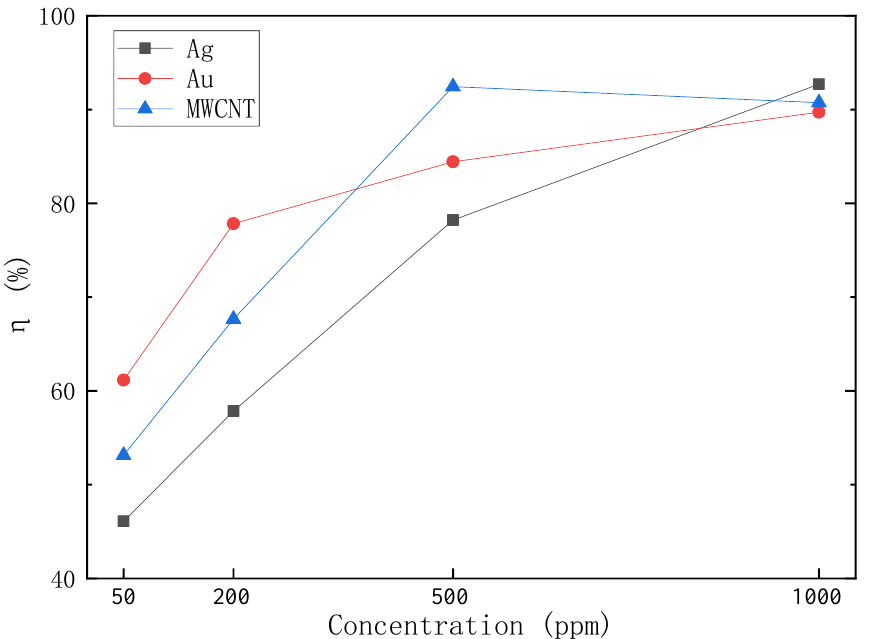
Figure 12. Solar–thermal conversion efficiency of Ag, Au, MWCNT, and SiO 2 Figure 12. Solar – thermal conversion efficiency of Ag, Au, MWCNT, and SiO 2 nanofluids.